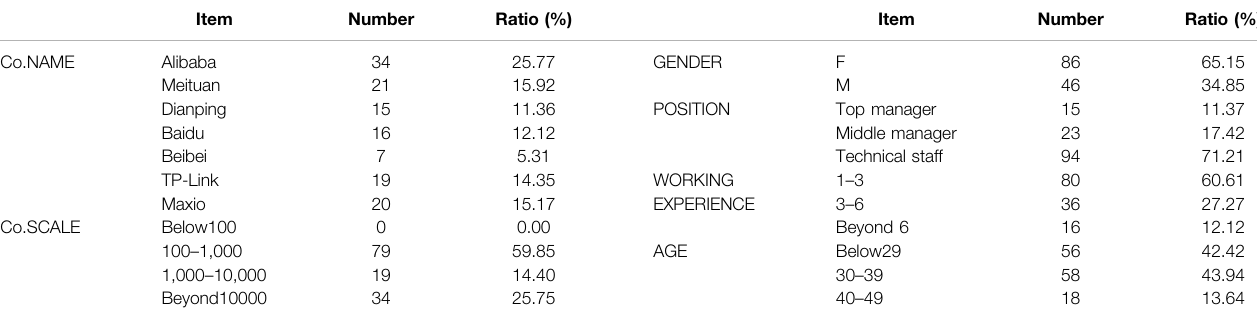
TABLE 1 | The sample characteristics distribution of the questionnaire.